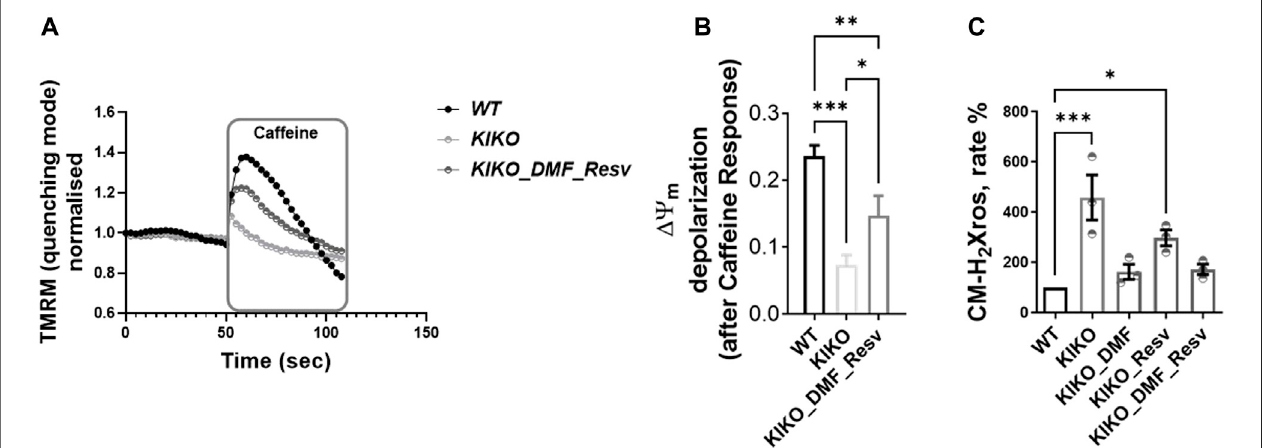
FIGURE3| A-B.Physiological ΔΨ mdepolarization tocaffeinerestored withDMF – Resv.C.DMF – ResvpreventsanmROSincrease incardiomyocytes.Forty-eight hours prior to experiments, the different compounds were administered at the following concentrations: 30 µM DMF and 100 µM Resv. (A) Kinetic curves of the ΔΨ m response to caffeine. (B) Measure of ΔΨ m depolarization after caffeine (mean ± SD; WT 0.23 ± 0.016; KIKO 0.07 ± 0.015; KIKO_DMF_Resv 0.15 ± 0.03; one-way ANOVA with Tukey ’ s multiple comparisons test). (C) Rate of mROS normalized to WT (mean ± SD; KIKO 460 ± 154; KIKO_DMF 163 ± 52; KIKO_Resv 297 ± 54; KIKO_DMF_Resv 172.4 ± 36; one-way ANOVA with Dunnett ’ s multiple comparisons test). *** p < 0.0005; ** p < 0.005; * p < 0.05; n > 3 independent